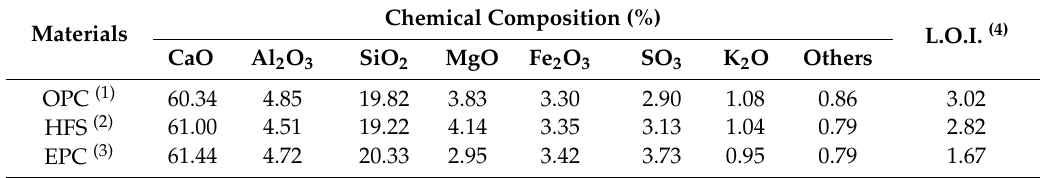
Table 1. Chemical composition of the used binders by X-ray fluorescence (XRF) analysis.